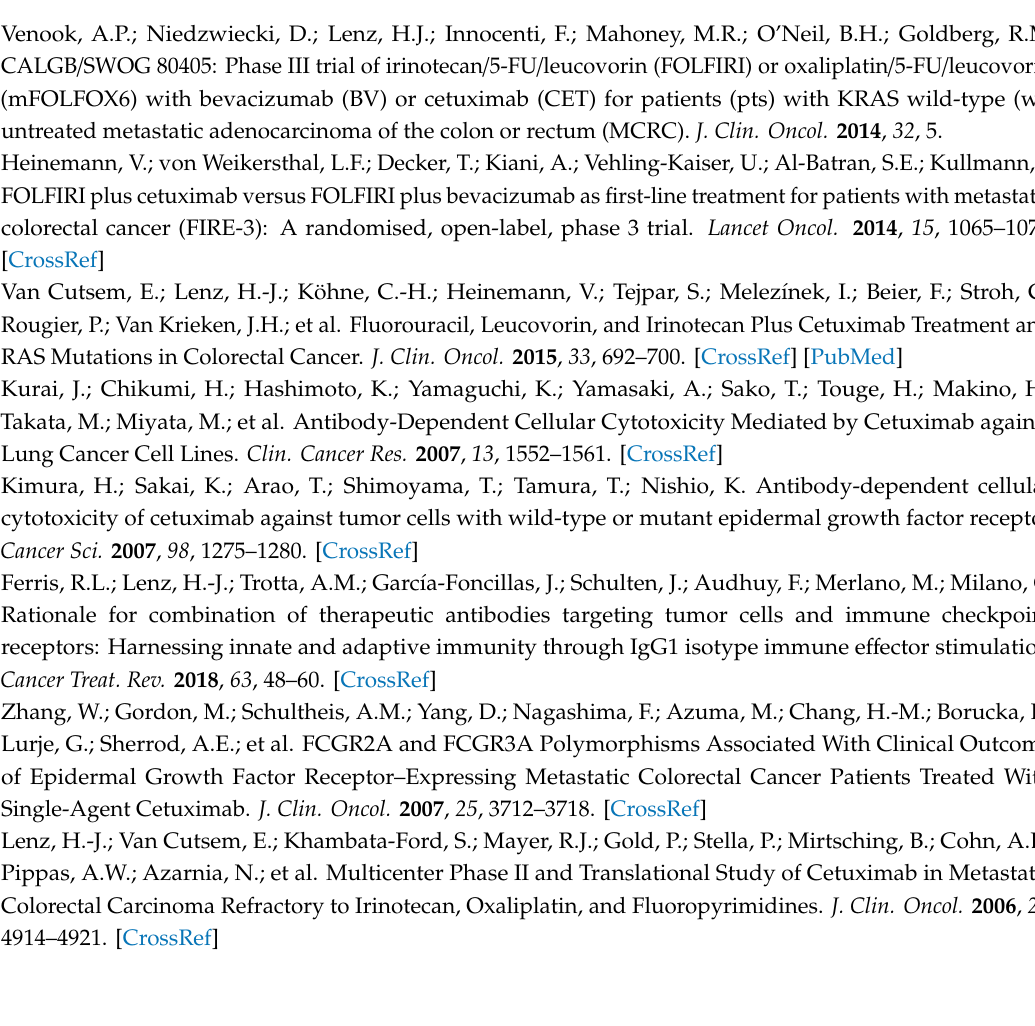
Table S1: Candidate single-nucleotide polymorphisms (SNPs); Table S2: Immune regulatory SNPs and outcomes in patients with advanced CRC treated with cetuximab-based therapy (training cohort, Italian + USC); Table S3: Immune regulatory SNPs and outcomes in patients receiving first-line FOLFIRI and cetuximab in FIRE-3 (validation cohort 1); Table S4: Immune regulatory SNPs and outcomes in Japanese patients receiving first-line cetuximab plus oxaliplatin-based therapy (validation cohort 2); Table S5: Immune regulatory SNPs and outcomes in patients treated with first-line FOLFIRI and bevacizumab in FIRE-3 (control cohort 1); Table S6: Immune regulatory SNPs and outcomes in patients receiving first-line FOLFIRI and bevacizumab in TRIBE (control cohort